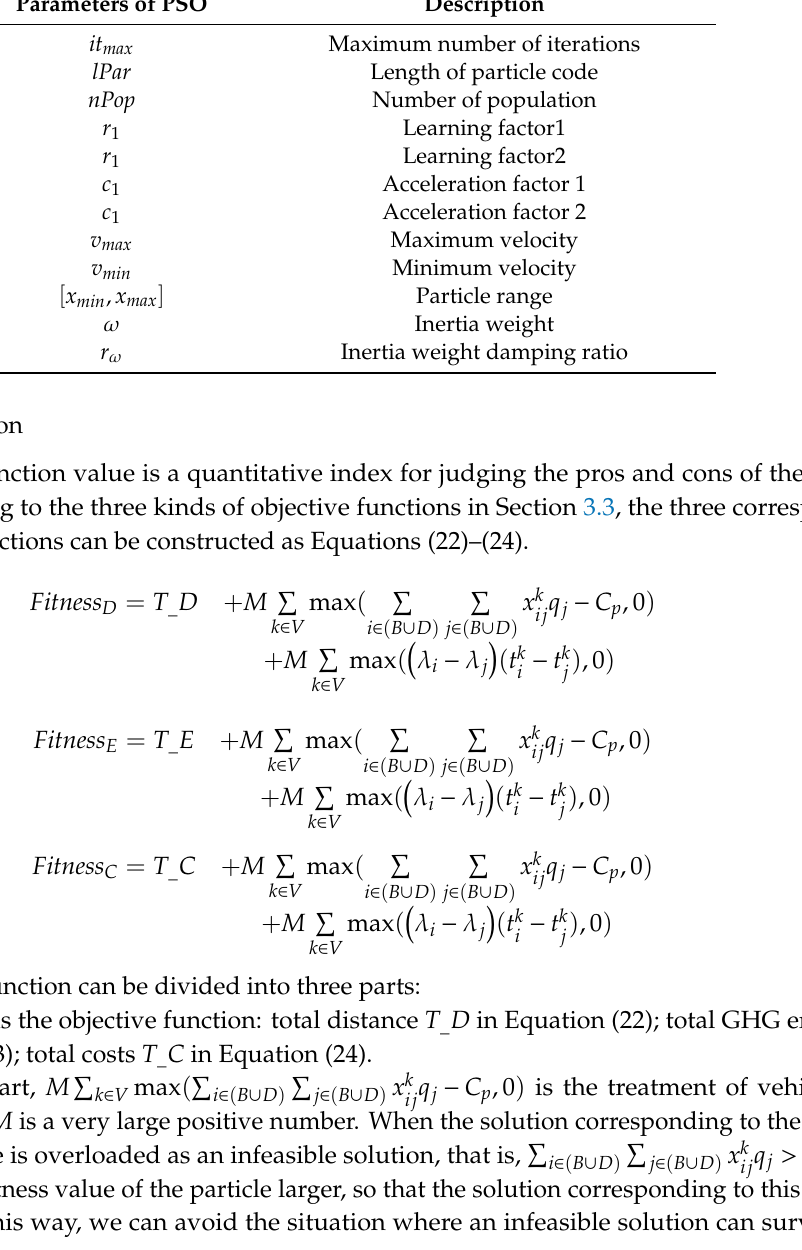
Table 4. Parameters of particle swarm optimization (PSO). Parameters of PSO Description Maximum number of